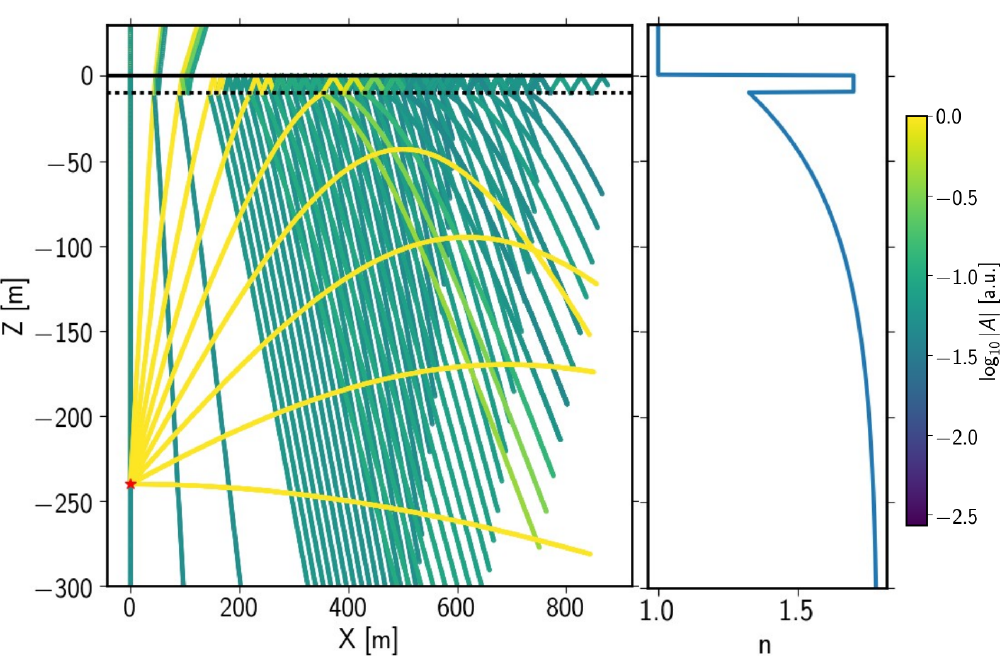
Figure 1. Example of propagated rays (left) in a two layer ice-model with varying index of refraction n in z direction (right). Colors denote the amplitude of the ray. Correction of the amplitude for length of the ray path is not included here to emphasize the e ff ect of multiple